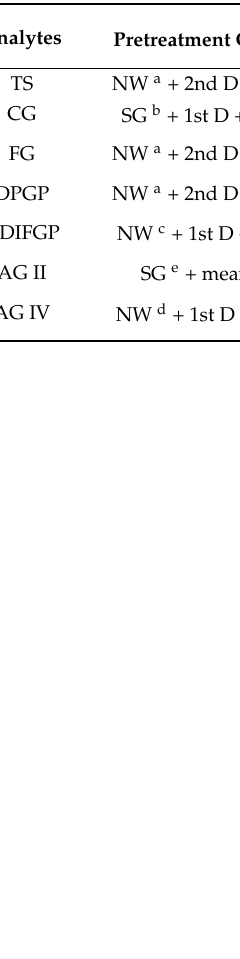
Table 4. Performance parameters of the seven calibration models.